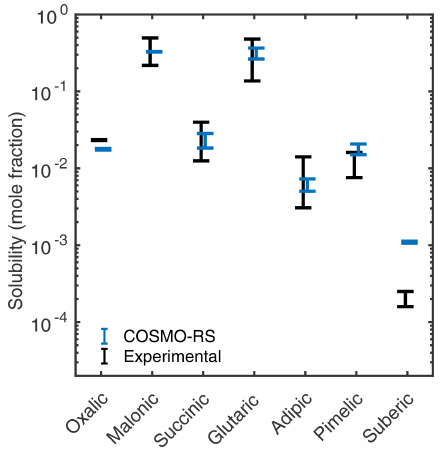
Figure 8. Estimated solubilities of the dicarboxylic acids compared to their experimental solubilities by Apelblat and Manzurola (1987) ( m = 2–4, 6), Apelblat and Manzurola (1989) ( m = 5), Apelblat and Manzurola (1990) ( m = 7–8), Saxena and Hildemann (1996) ( m = 2–6), Omar and Ulrich (2006) ( m = 2), Zhang et al. (2013) ( m = 2– 8), Brooks et al. (2002) ( m = 4), Song et al. (2012) ( m = 5), and O’Neil (2013) ( m = 5), at 298.15K. The lower and upper limit sol- ubility estimates are obtained using the highest and lowest free ener- gies of fusion (estimated from experimental melting point and heat of fusion values in Table 1),